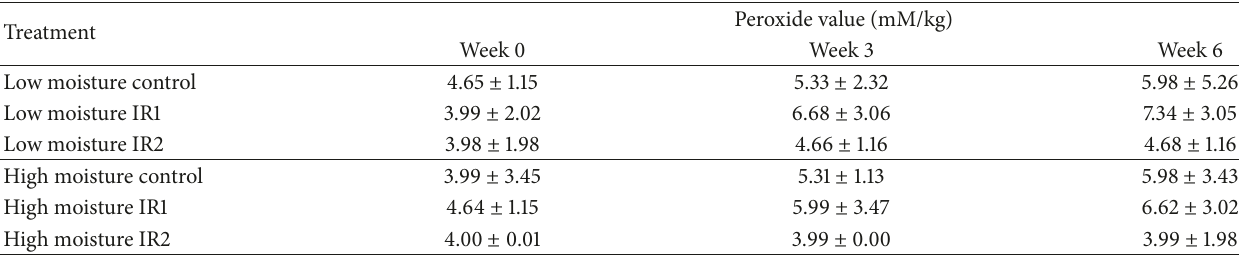
Table 5: Peroxide values of the blanched peanut